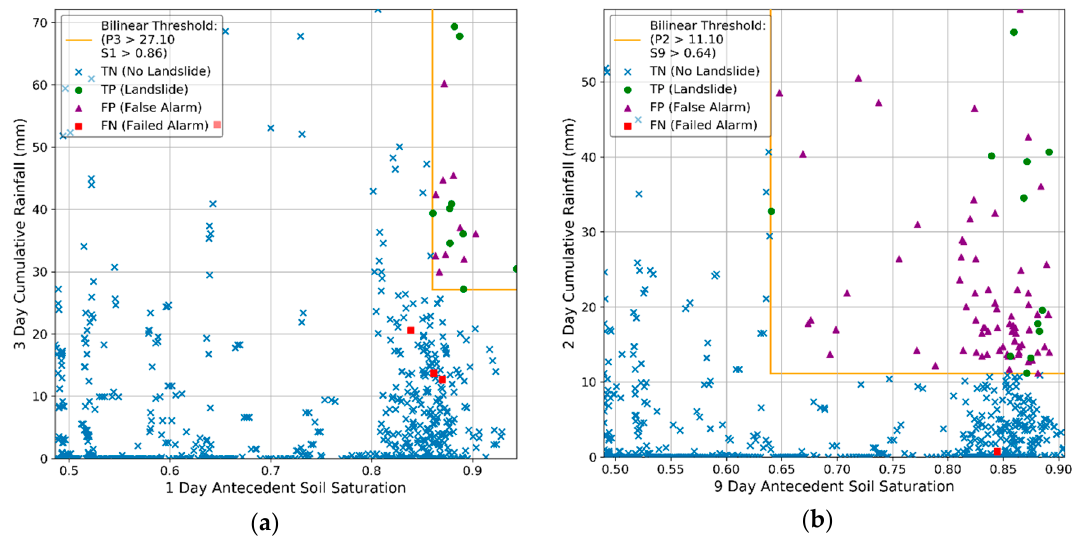
Figure 6. Seattle area hydro-meteorological threshold plots showing competing thresholds optimized with: ( a ) threat score; ( b ) optimal point statistic. Predicted landslide(s) are TP; false alarms are FP; no landslides are TN; missed landslide(s) are FN.